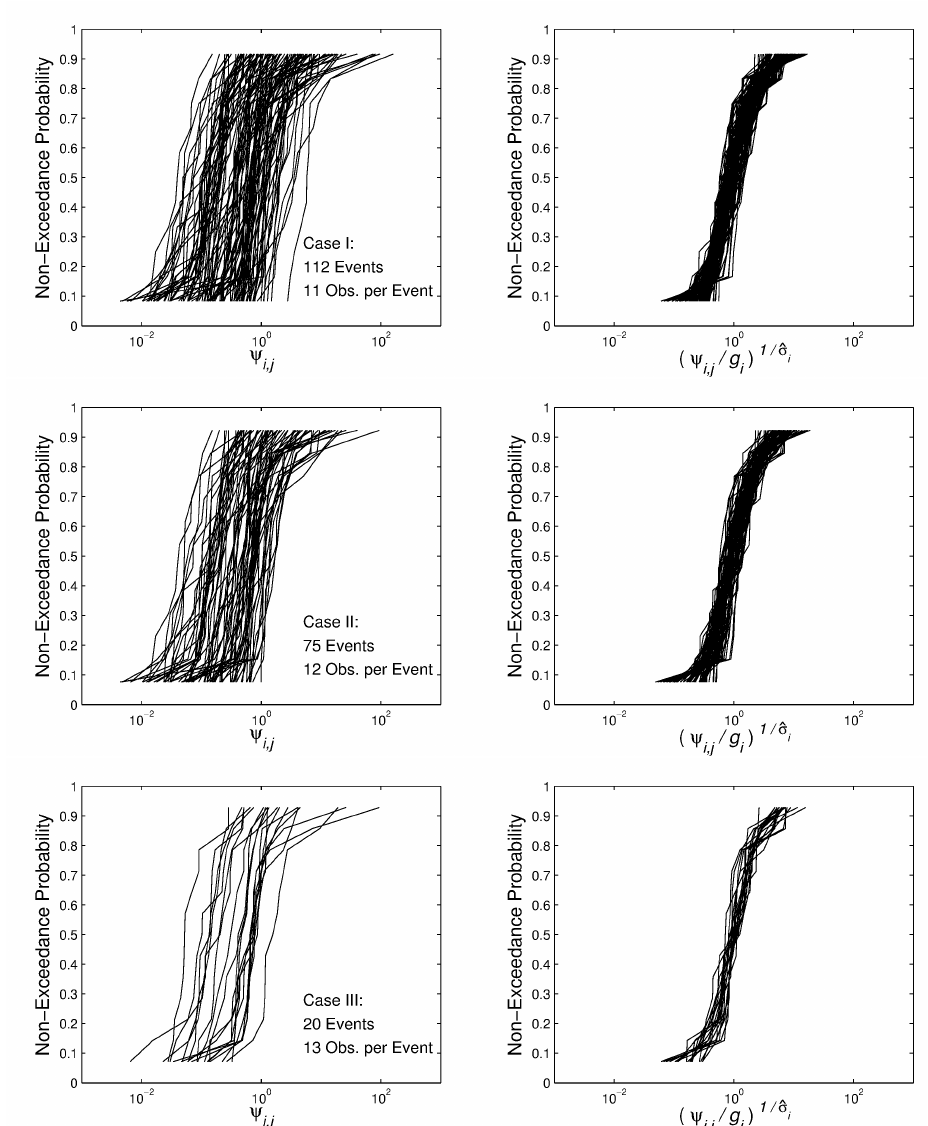
Fig. 4. Left: Semi-log plot of empirical CDFs of runoff-loss ratios at the unnested basin scale, ψ i,j , for Cases I to III. Each distribution represents a rainfall-runoff event. Right: Semi-log plot of corresponding CDFs of rescaled runoff-loss ratios, ( ψ i,j /g i ) 1 / ˆ σ i .